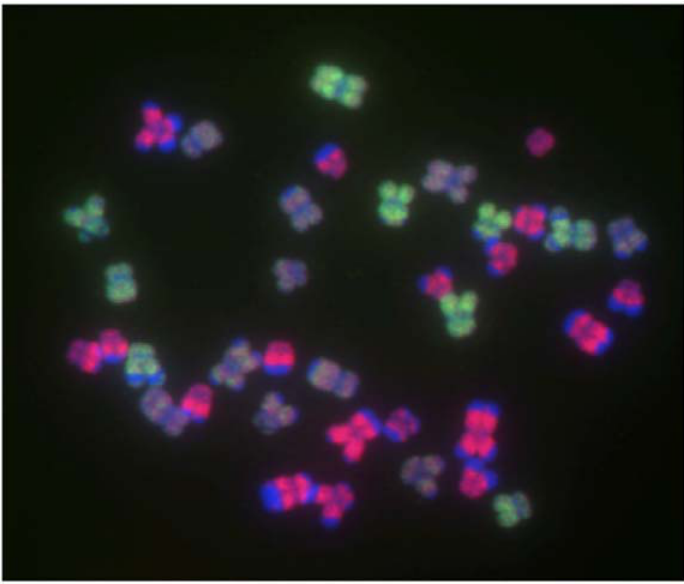
Figure 6. FISH to a partial root tip metaphase preparation of a Tripsacum x Zea trispecies hybrid (3 n = 38). Chromosomes are hybridised by a mixture of genomic DNA clones, which have been directly labelled with fluorophores. Chromosomes can be identified as originating from T. dactyloides (red signal), Z. mays (green signal) or Z. diploperennis (mixed red and green signal); chromosomes are counterstained with DAPI (blue). Photo by Tatiana Arias, courtesy of James